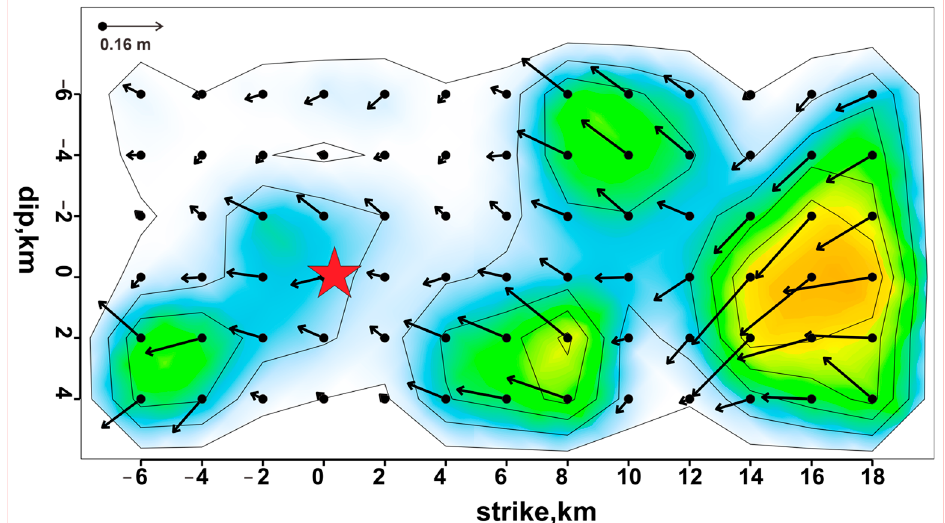
Figure 8. 2D spatial slip distribution of the inversion results (arrows indicate the direction of the slip